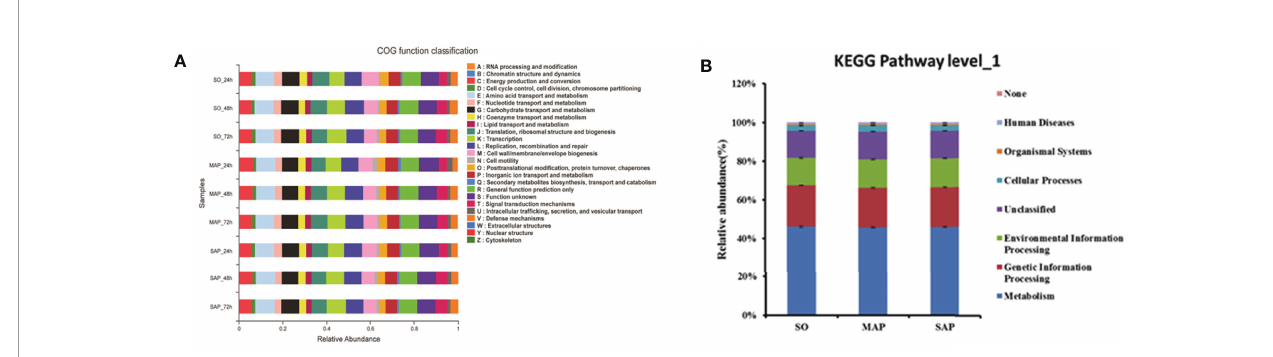
FIGURE 6 | The function predicted for 16S rRNA by PICRUSt. (A) For COGs in three groups at three time points. (B) For KEGG pathway level_1 in three groups. SO, Sham operation; MAP, Mild acute pancreatitis and SAP, Severe acute pancreatitis; PICRUSt, Phylogenetic Investigation of Communities by Reconstruction of Unobserved States (PICRUSt); KEGG, Kyoto Encyclopedia of Genes and Genomes. Data are shown as mean ±